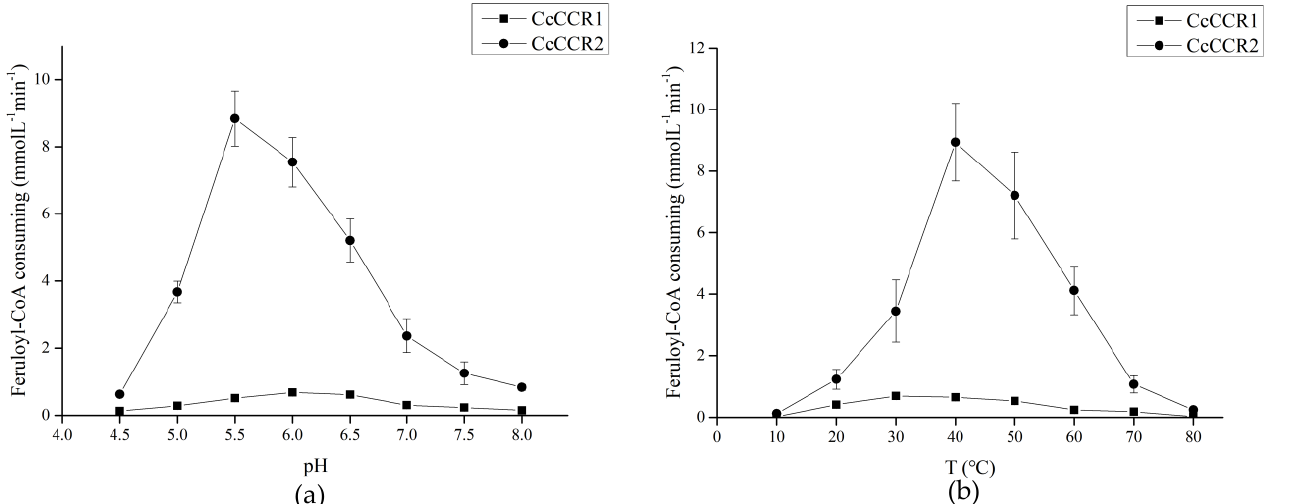
Figure 6. The pH ( a ) and temperature ( b ) profiles for recombinant CcCCR1 and CcCCR2 activities. 3.6. The Correlation between Expression of CcCCRs and Contents of Capsaicin, Lignin,